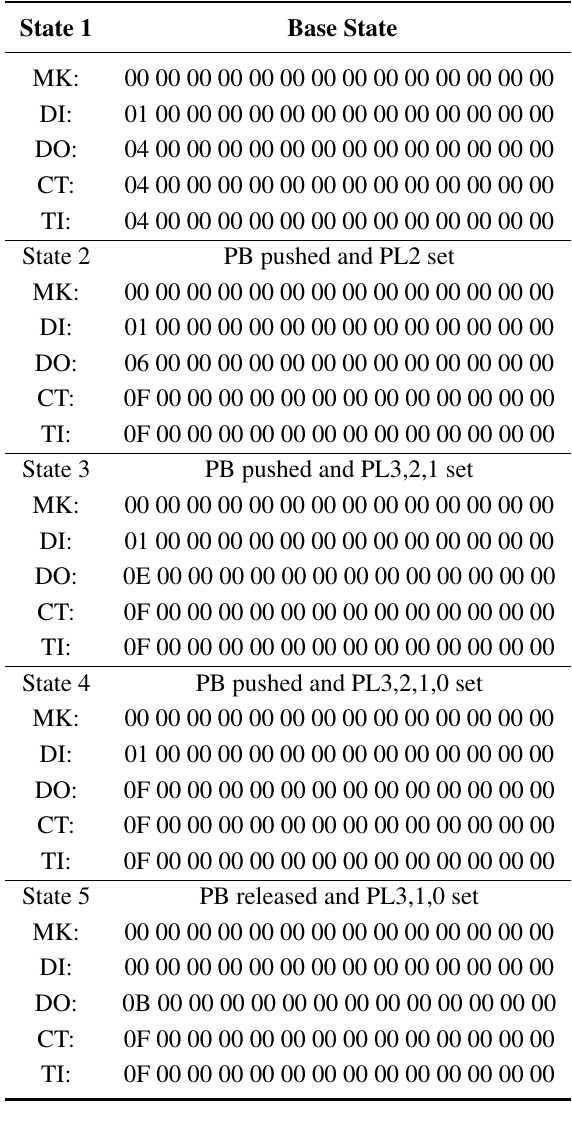
Table 1. Sensor captures PLC state transitions